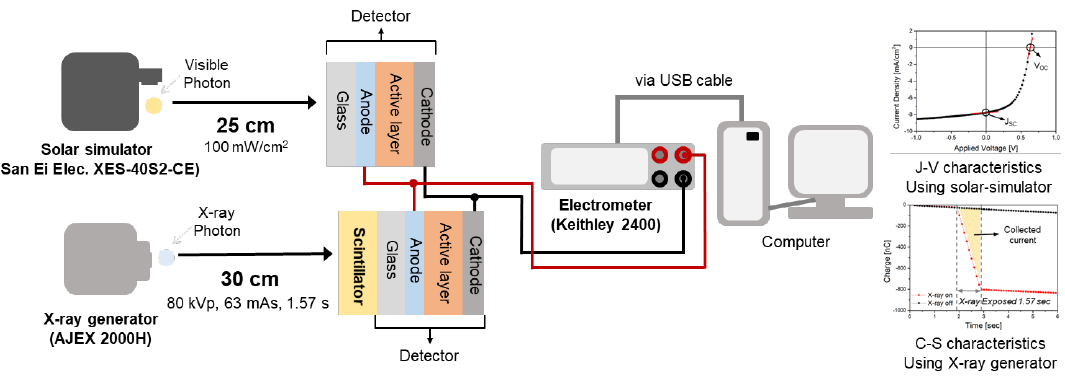
Figure 3. Schematics diagram of experimental setup for measuring the solar parameters (J SC , R S , and power conversion efficiency (PCE)) and X-ray parameters (collected current density (CCD), dark current density (DCD), and sensitivity).